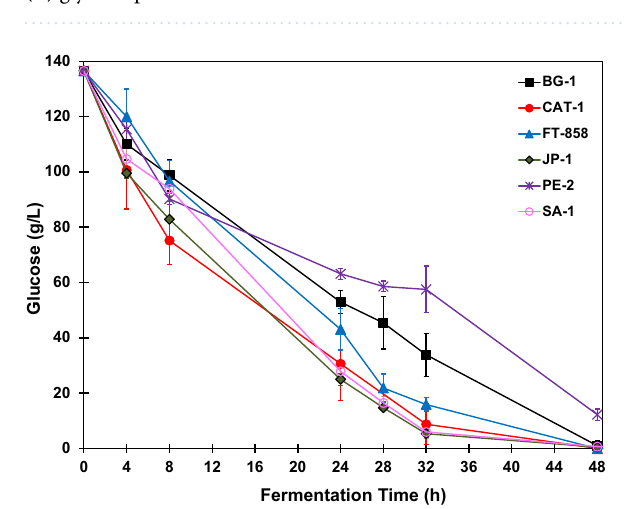
Figure 6. Box charts and means comparison using Tukey mean-difference plot for (A) ethanol production and (B) glycerol production related to BRS PAMPA rice fermentations with S. cerevisiae strains.